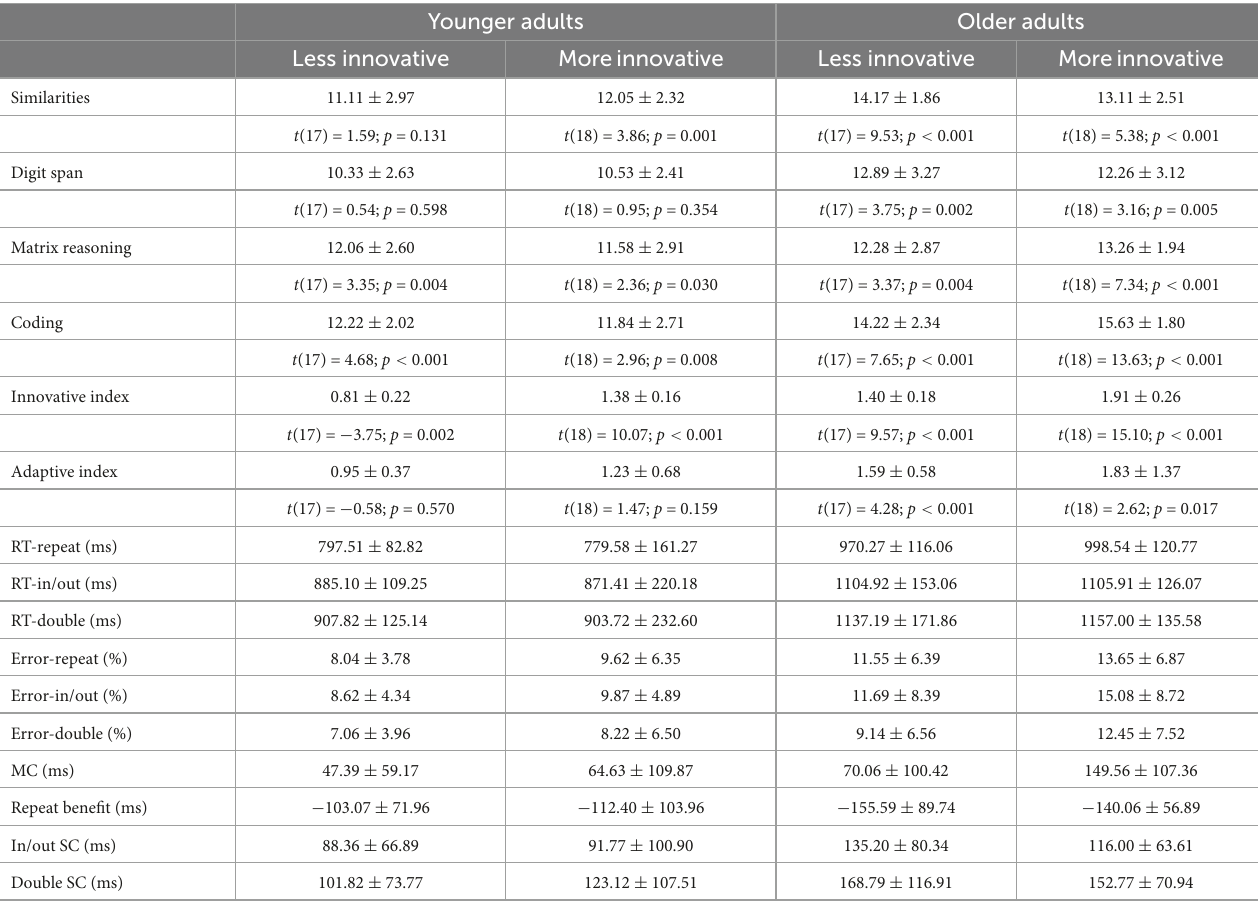
TABLE 3 Summary of behavioral data for the more and less innovative groups (mean ± SD and t -test results for the difference from population average in test scores–for the WAIS-IV subtests’ scaled scores the corresponding age-group’s mean score is 10, and for the two creativity-styles’ index the corresponding age-group’s mean score is